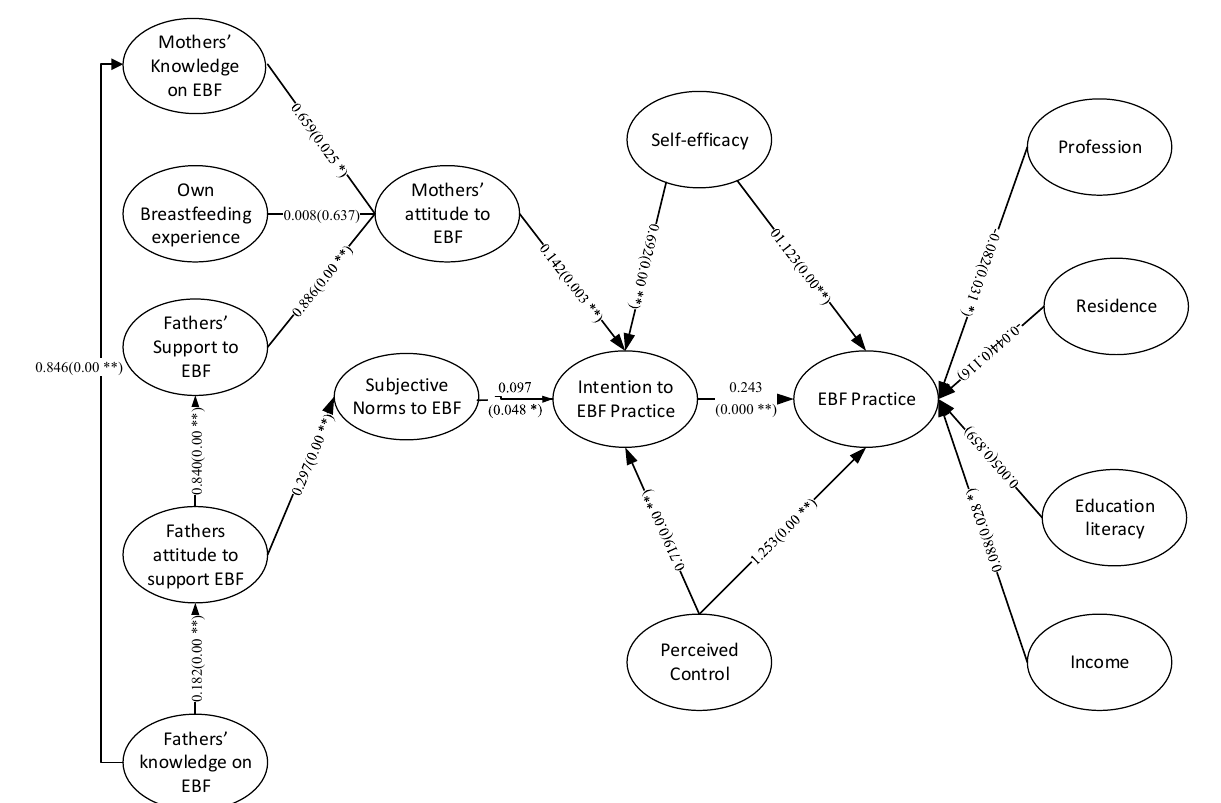
Figure 2. SEM analysis on father’s knowledge and attitude on mother’s EBF knowledge, attitude and practice in Bangladesh (on complete sample). * Significant at p < 0.05; ** Significant at p < 0.01.